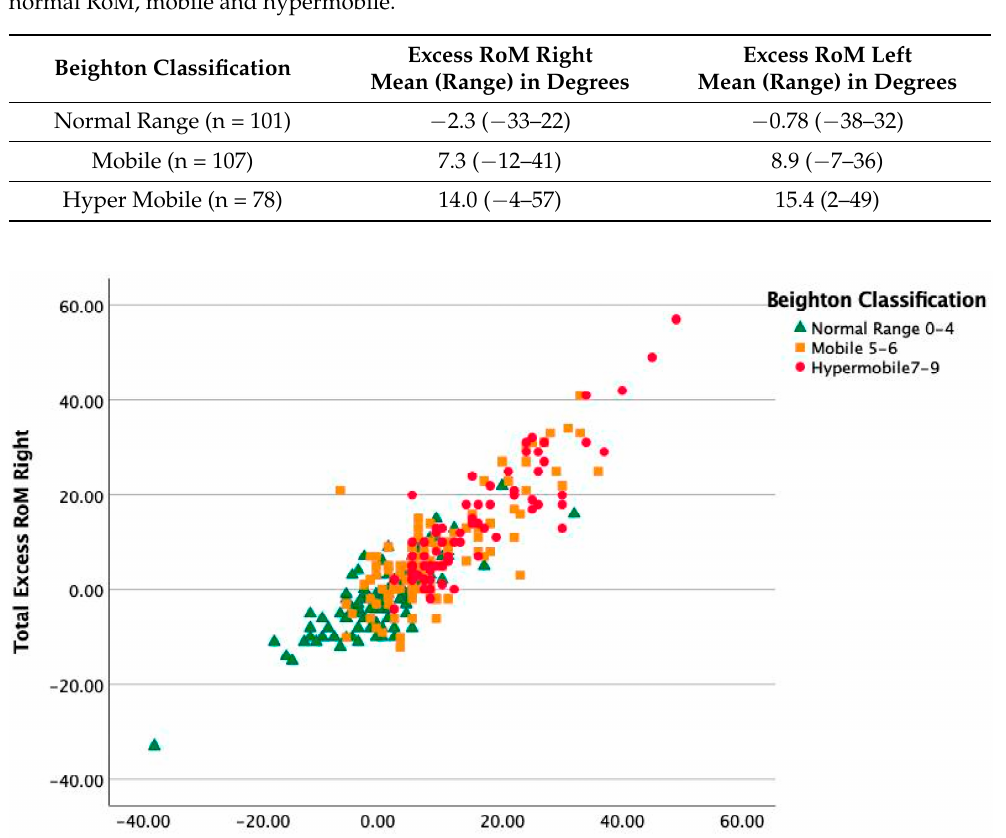
Table 3. Excess degrees of movement in the 5th fingers, elbows, and knees in children classified as normal RoM, mobile and hypermobile.